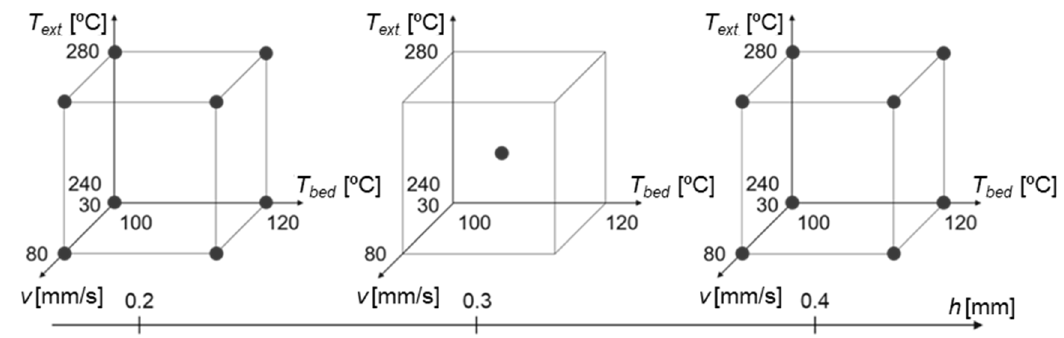
Figure 3. Black points indicate the conditions evaluated for the 2k full factorial DoE.